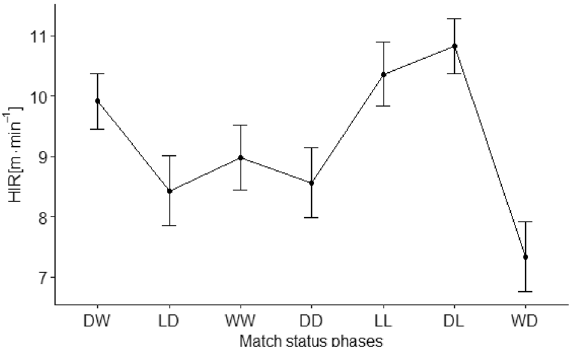
Figure 2. Distance covered at speeds over 19.8 km h −1 (HIR) on seven match status phases (mean ± SE). DW (Drawing to Winning); LD (Losing to Drawing); WW (Winning to Winning); DD (Drawing to Drawing); LL (Losing to Losing); DL (Drawing to Losing); WD (Winning to Drawing).